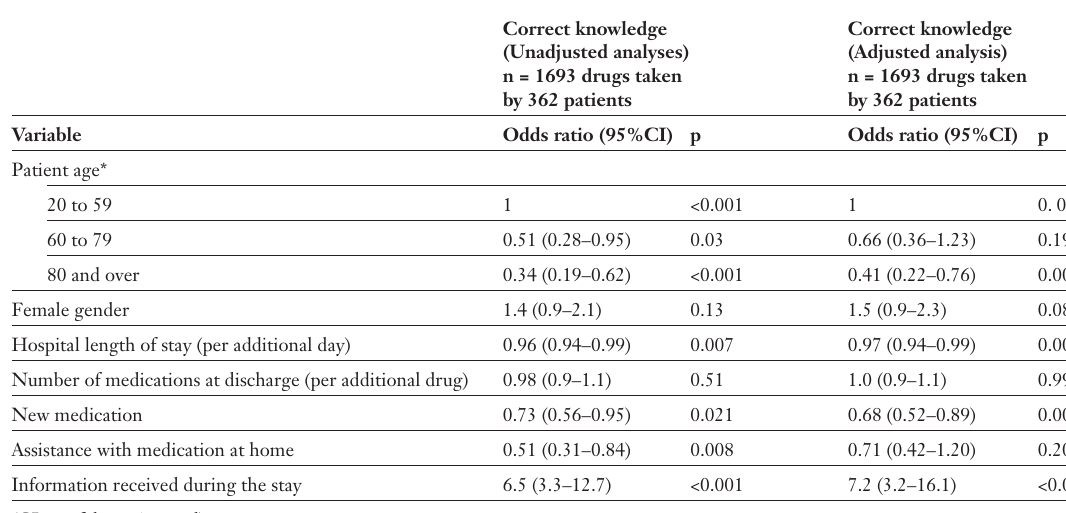
Table 2 Association between patients’ and medica- tions’ characteristics and knowledge of the reasons for taking medications (unad- justed and adjusted